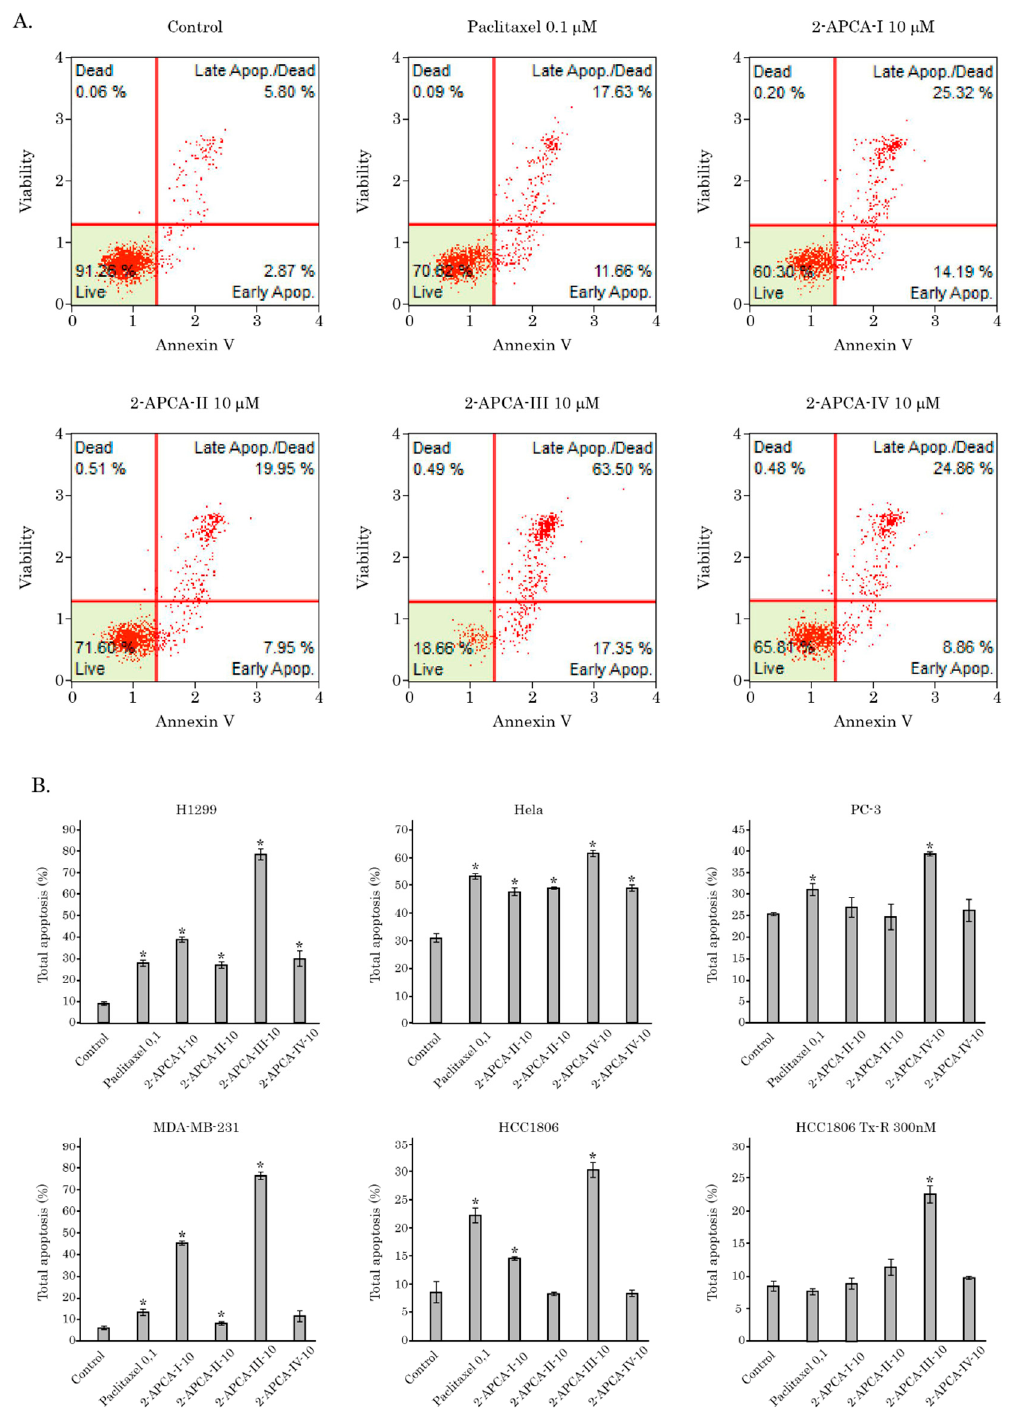
Figure 7. FACS analysis for apoptotic markers in cancer cells treated with 2-APCAs or PTX. ( A ) Representative dot-plots histograms illustrating an increase of early (annexin V-positive/propidium iodide (PI)-negative) and late (double-positive) apoptotic cells in the HCC1806 TNBC cancer cell line treated for 24 h with DMSO (control), 2-APCAs (I-IV), and paclitaxel (positive control). ( B ) Quantitative analysis of apoptotic cells after treatment with DMSO (control), 2-APCAs (I-IV), and PTX (positive control) for 24 h. * p < 0.05.